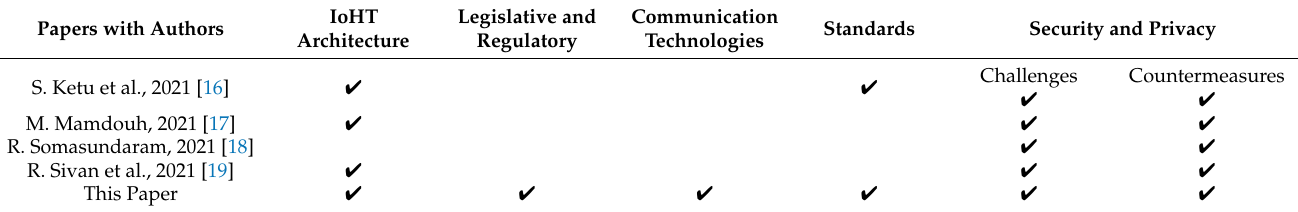
Table 1. Comparison of this work with the recent IoHT